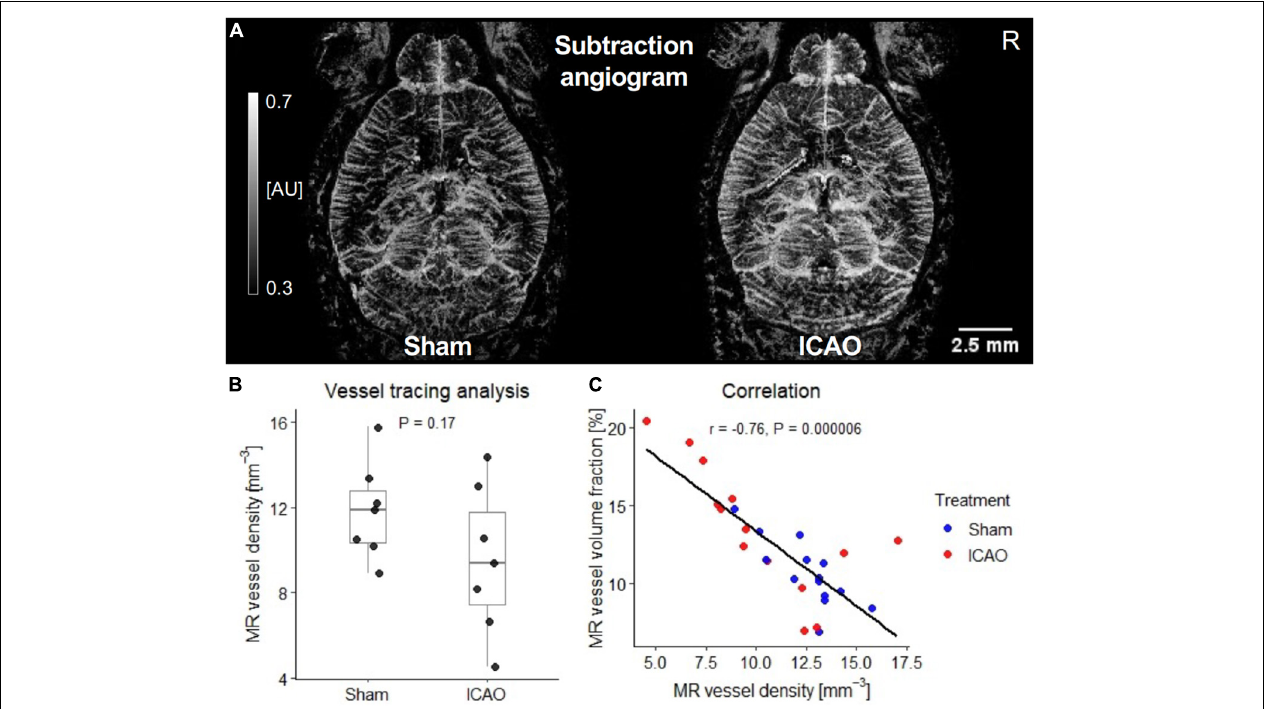
FIGURE 1 | Quantitative contrast enhanced magnetic resonance angiography (CE-MRA) subtraction angiogram analysis 21 days after ICAO or Sham. (A) Iron oxide nanoparticle-based MR subtraction angiograms in gray-scaled arbitrary units (AU) clearly visualized a stronger enhancement across both hemispheres on Day 21 after ICAO compared to Sham. (B) In contrast to this clearly visualized effect, semi-automated MR vessel density analysis yielded a lower instead of higher vessel density in the right neocortex after ICAO ( n = 7 per group). (C) Relationship between MR vessel density and the corresponding vessel volume fraction in neocortex measurements from both hemispheres described by Spearman’s rank correlation coefficient ( n =